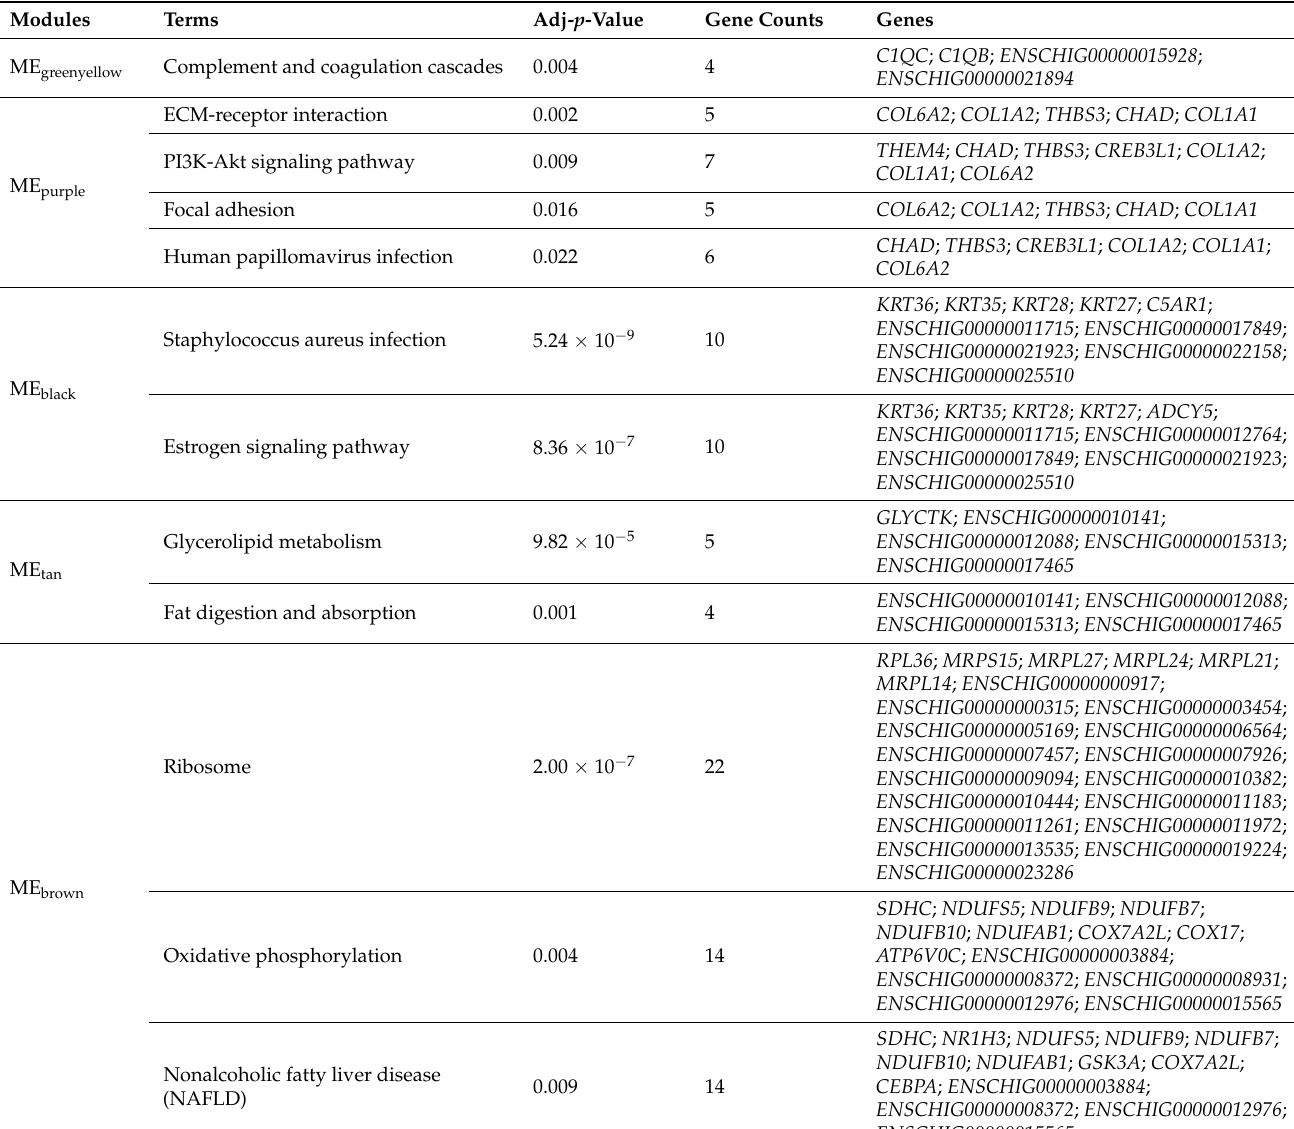
Table 1. KEGG pathways in coexpression